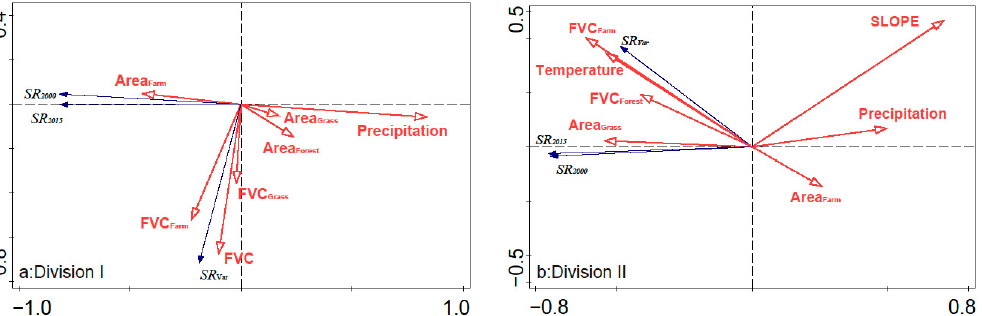
Figure 7. RDA of WEPSs and significant environmental factors in Divisions I ( a ) and Division II ( b ) (explained rate: 63.1% in division I; 58.1% in division II). SR var : Variation in WEPSs from 2000 to 2015; SR 2000,2015 : WEPS in 2000 or 2015; FVC: Fractional vegetation coverage.